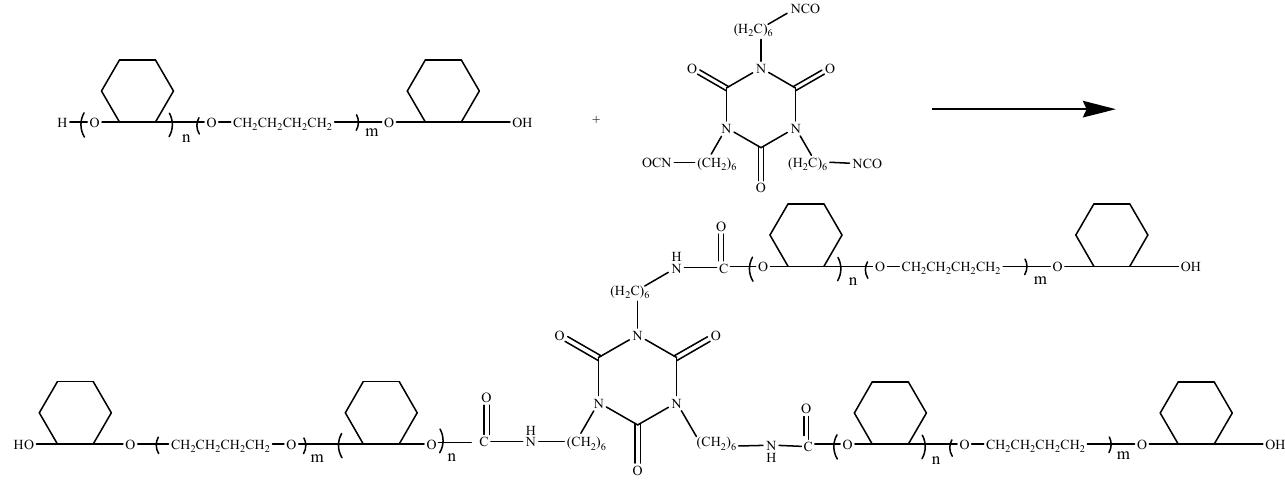
Polymerization is generated by the reactants CHO-THF copolyether, and HDI trimer. The reaction between high-reactivity isocyanate groups of the HDI trimer and hydroxyl groups of the copolyether is provoked by the catalysis of dibutyltin dilaurate. The reaction mechanism is illustrated in Scheme 2.